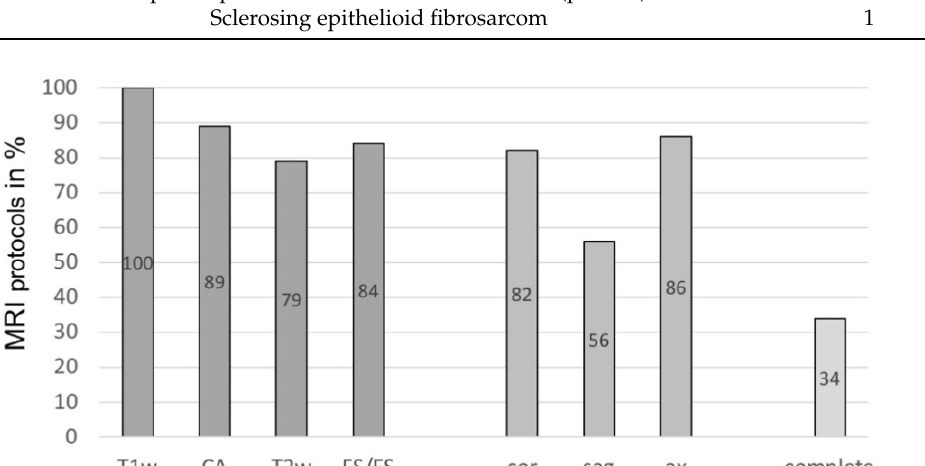
Figure 2. Percentage of European Society for Musculoskeletal Radiology (ESSR) recommended sequences and planes included in magnetic resonance imaging (MRI) protocols. T1w = T1-weighted; CA = use of contrast agent; T2w = T2-weighted; FS/FS = fluid-sensitive/fat-saturated sequence; cor = coronal plane; sag = sagittal plane; ax = axial plane; complete = all sequences/planes included .